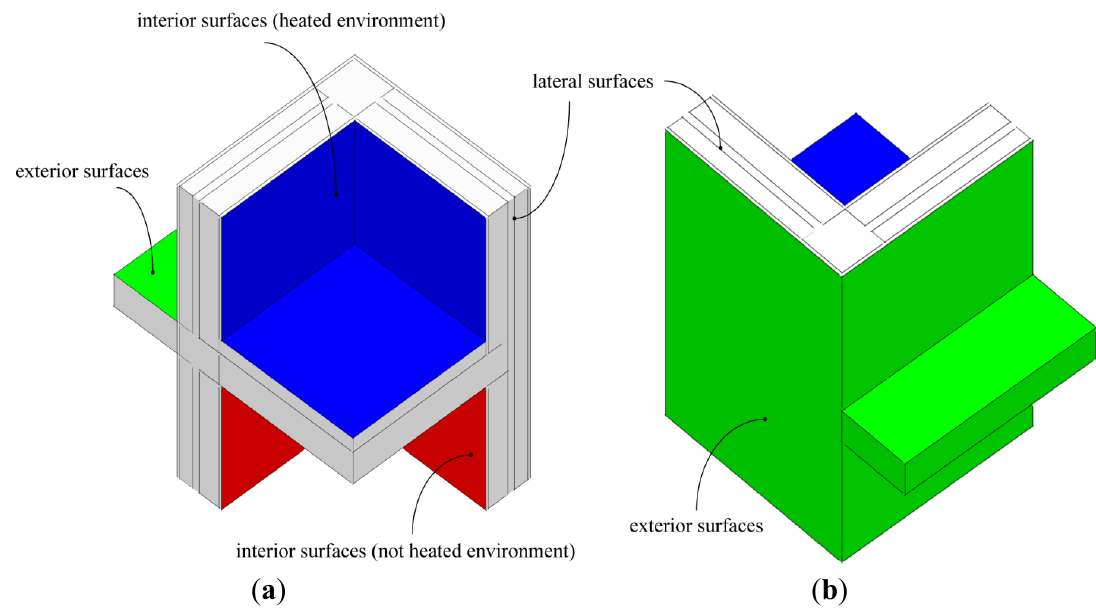
Figure 5. Computational domain considered: interior view ( a ) and exterior view ( b ).